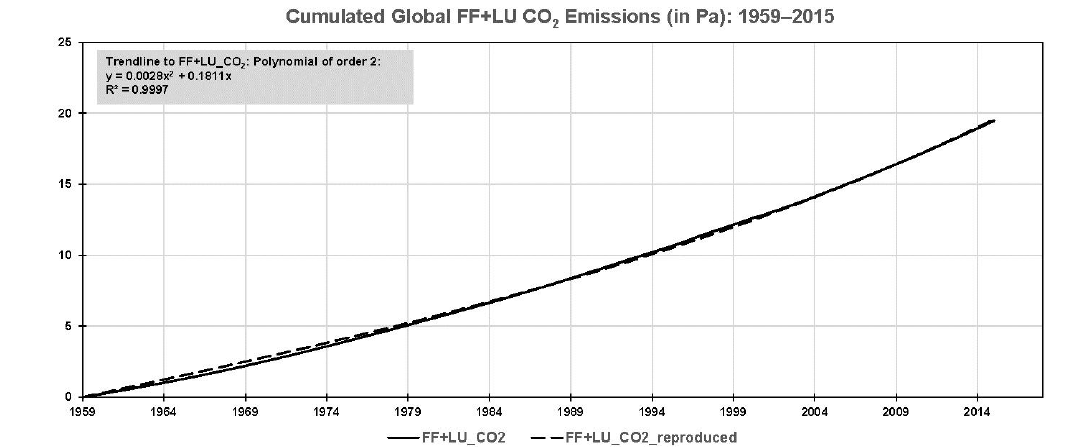
Figure 5. Case 0: K/D and α on the right side of Eq. (2a) are tuned to reproduce the stress σ ( t ) on the left side of that equation, given by the monitored (but cumulated) CO 2 emissions from fossil fuel burning and land use activities (in Pa). The value resulting for K/D complies with its lower limit deemed possible based on the uncertainties derived for K and D in Sect.